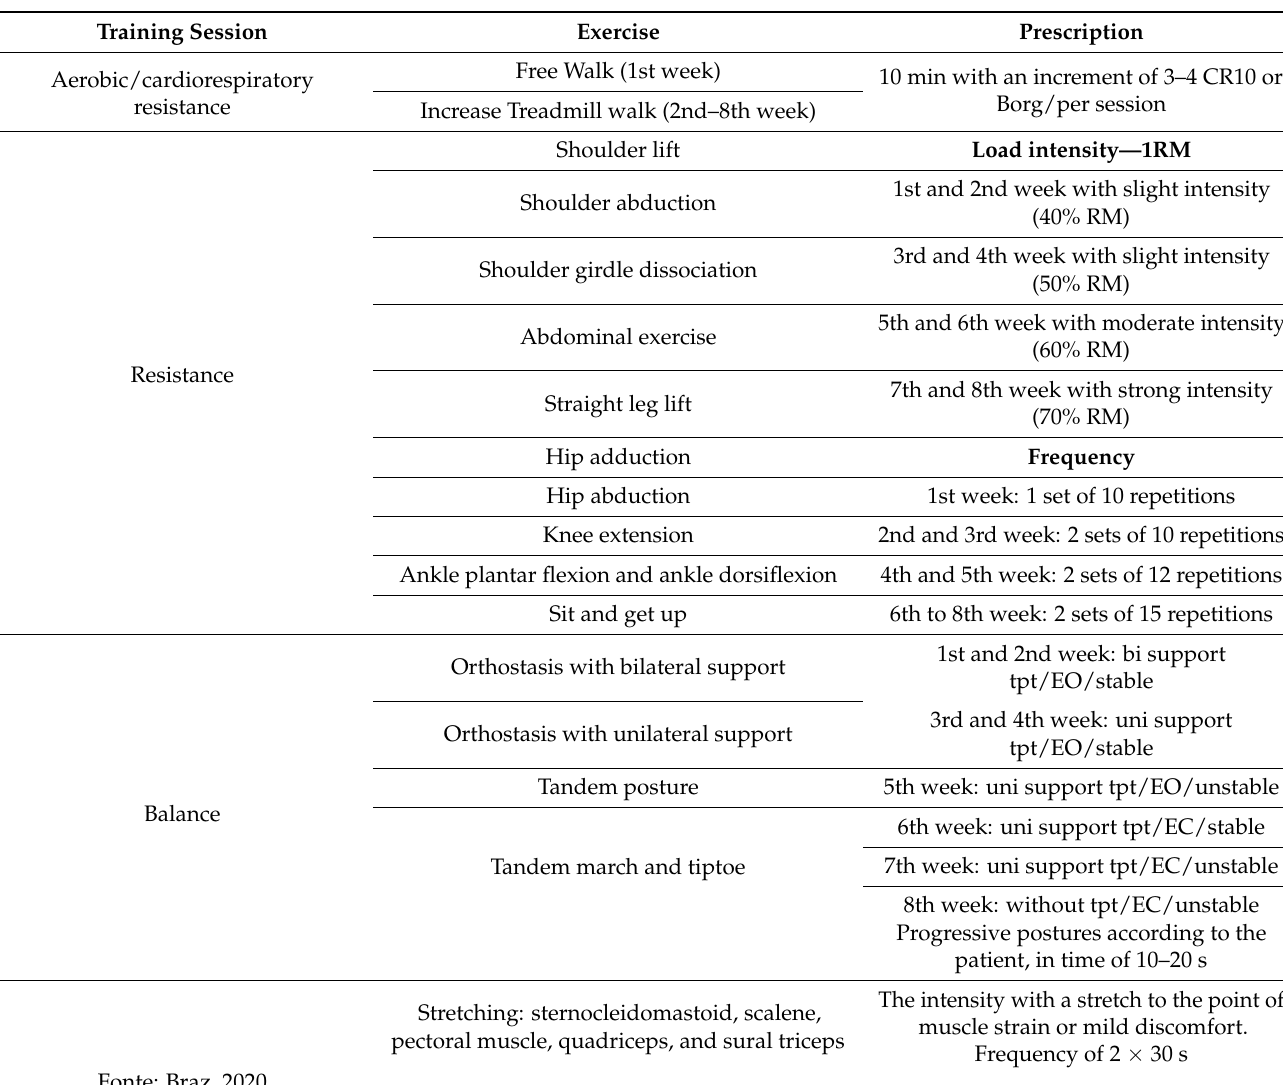
Table 1. Multicomponent training protocol